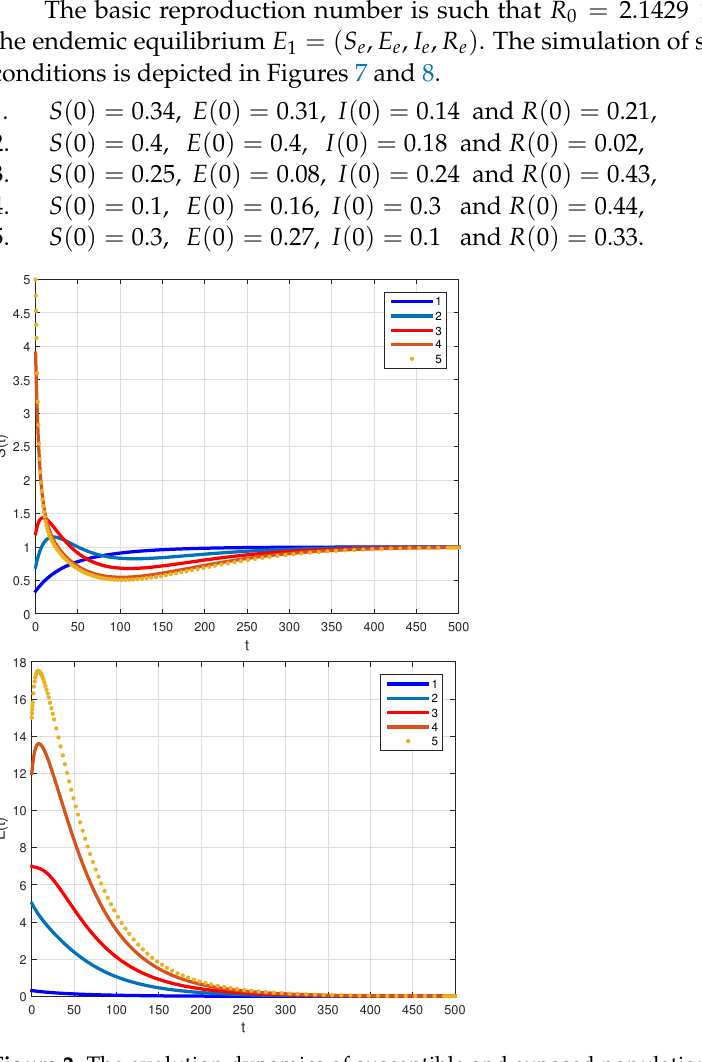
Figure 2. The evolution dynamics of susceptible and exposed population vs. time, R 0 = 0.1087 <